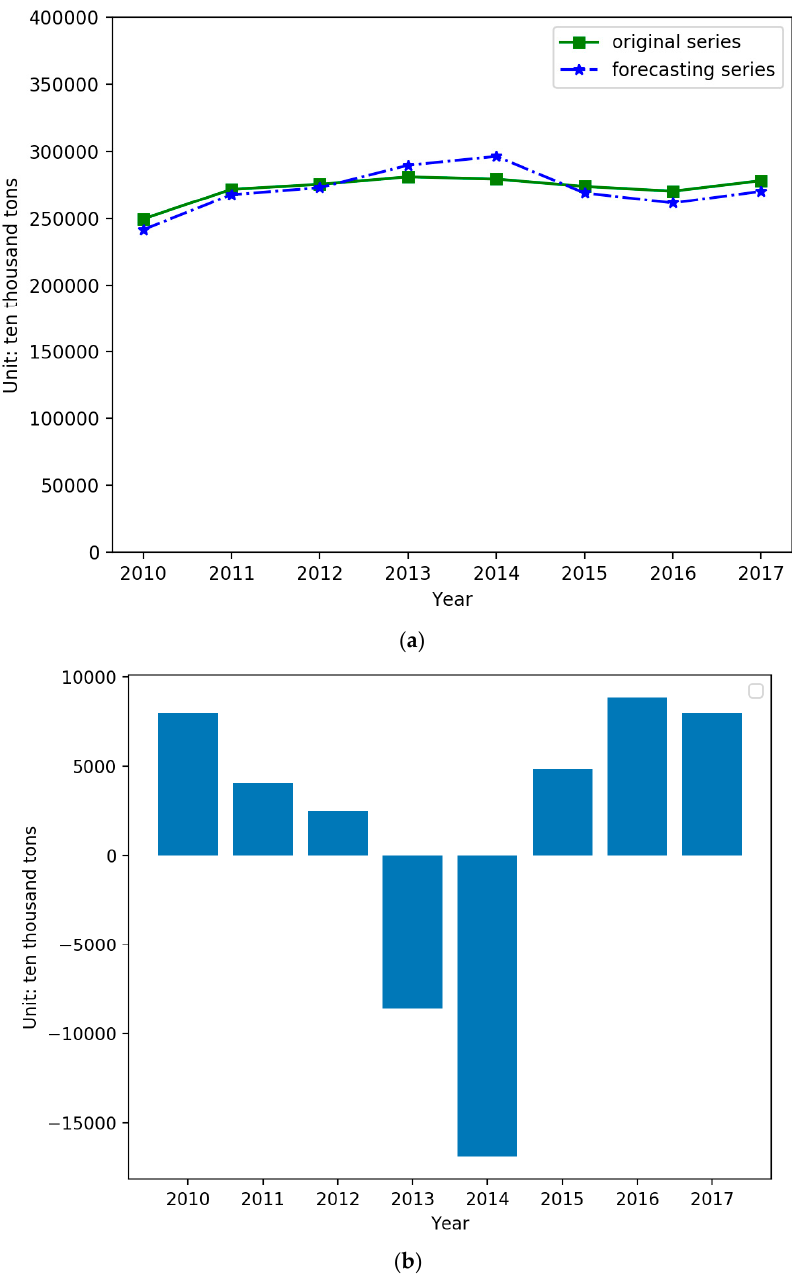
Figure 4. The prediction and residual figures by IGSA–SVM. ( a ) The prediction figure; ( b ) the residual figure.